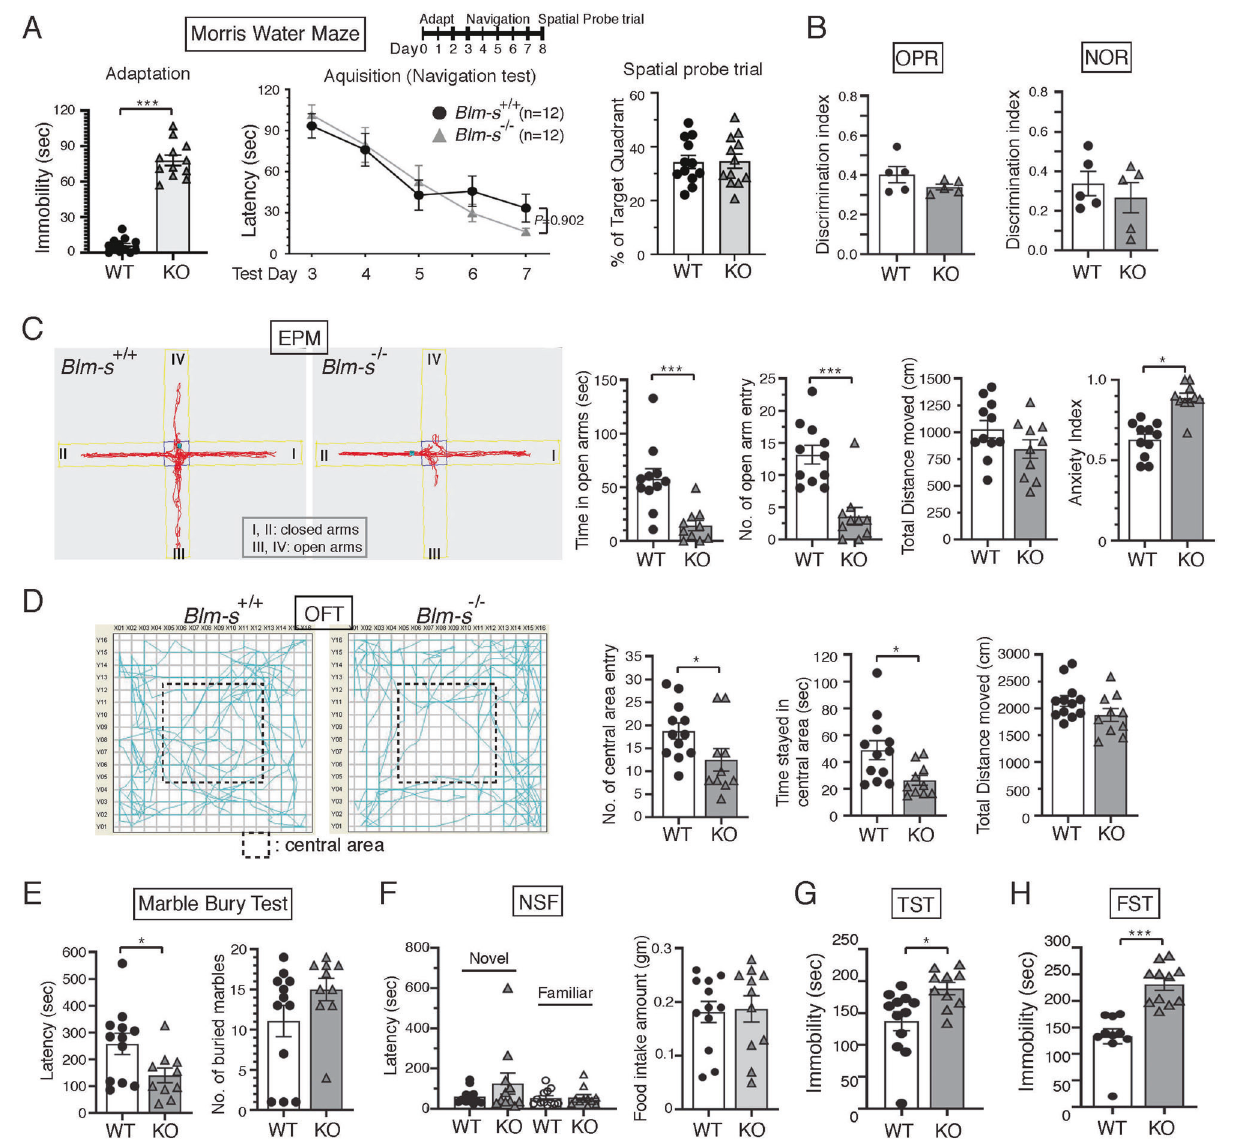
Fig. 2 Effects of BLM-s de fi ciency on memory task and emotional control. A Experimental timeline for Morris water maze (MWM) test. Bar graphs show immobility duration of the mice in adaptation period (left) and the percentage of mice crossing the target quadrant during spatial probe trial (right). Line graph is for the escape latency of the mice to search for hidden platform during navigation stage. Blm-s − / − mice (KO) showed prolonged immobility during adaptation period in the MWM test (*** P < 0.001, Two-tailed Student ’ s t -tests). However, both groups showed signi fi cant negative regression learning curve as the block effect during navigation test (Two-way repeated measures ANOVA with Holm-Sidak post hoc comparison) and spent more time in the target quadrant than in the other three quadrants in spatial probe trial (Two-tailed Student ’ s t -tests). Errors are shown as mean ± s.e.m. n = 12 and 12 mice for WT and KO, respectively (see Supplementary Fig. S3A for representative swimming path of KO and WT mice during the MWM arena). B NOR (novel-object recognition) and OPR (object-place recognition) short-term memory (performed 90 min after encoding phase) were not affected by BLM-s de fi ciency. (See Supplementary Fig. S4H – J for graphic depict of both task arena and for discrimination ratio during the retrieval phase of long-term memory test performed at 7-day after training/encoding). C – F Evaluation of anxiety-like behaviors by elevated plus maze (EPM) ( C ), open fi eld test (OFT) ( D ), marble burying test ( E ), and stress-induced novelty suppressed feeding test (NSF) ( F ). KO mice spent less time and number of entry in the elevated open arms during EPM test ( C ) and in the center during the open fi eld assay ( D ) ( n = 10 KO and 11 WT mice in EPM; n = 10 KO and 12 WT mice in OFT; 3 independent experiments. *** P < 0.001, * P < 0.05, Two-tailed Student ’ s t -test. Graphs indicate mean ± s.e.m.). Marble burying index (30 min) by the latency time for starting to dig marbles is much lower in KO mice ( n = 10 KO and 12 WT mice; * P < 0.05, Mann – Whitney rank sum test), although differences in the total number of buried marbles were not seen ( E ). KO mice after fasting tended to hesitate in the fi rst bite of food under novel environment in spite of similar food intake amount ( n = 11 KO and 12 WT mice; Two-tailed Student ’ s t -test) ( F ). G , H Assessment of depression-like behavior by tail-suspension test (TST) ( G ) and forced swimming test (FST) ( H ). KO mice expressed helpless immobility in both tests. Data are shown with errors as mean ± s.e.m. ( n = 10-11 KO and 10 – 12 WT mice; Two-tailed Student ’ s t